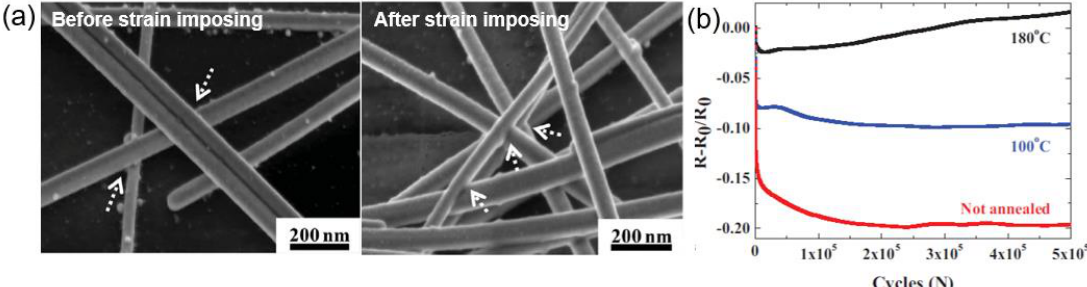
Figure 14. ( a ) SEM images of Ag NW networks: before and after imposing strain for 10,000 cycles at a bending strain of 1%. ( b ) Comparison of un-annealed and annealed (100 °C and 180 °C for 25 min) Ag NW networks under bending tests. Reproduced with permission from [64]. Copyright 2014 WILEY-VCH Verlag GmbH and